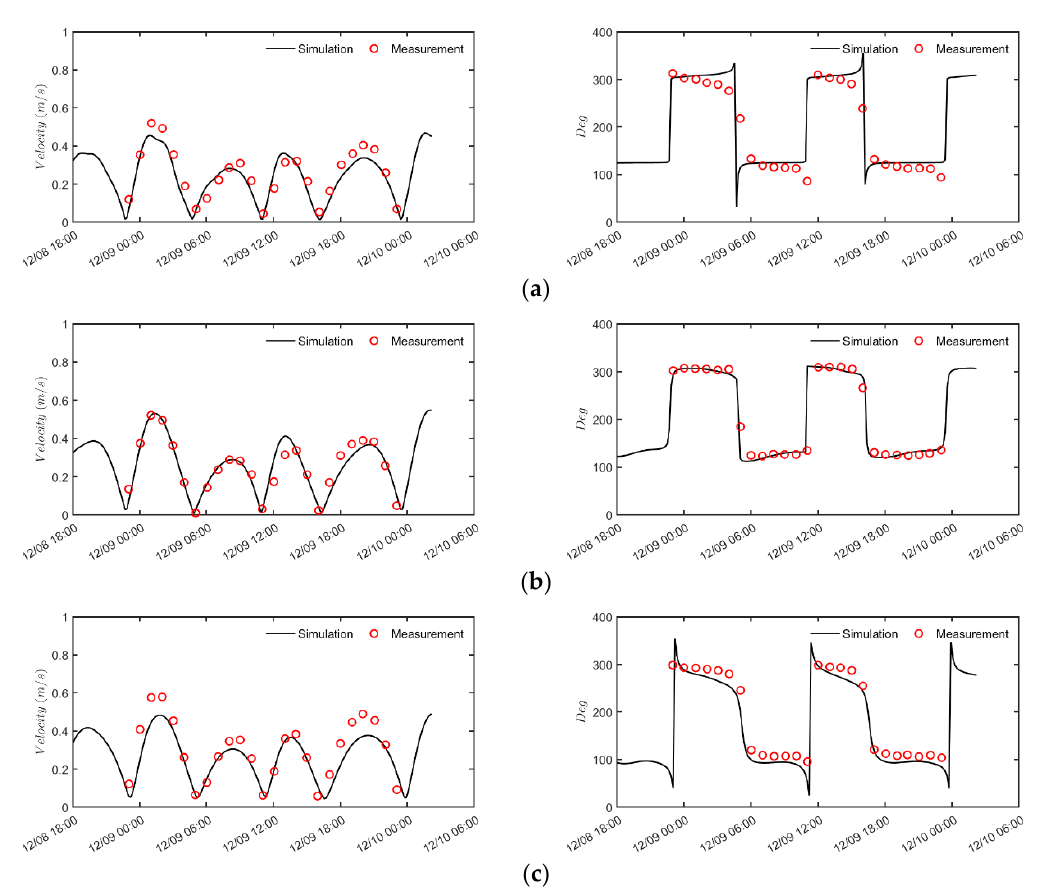
Figure 10. Comparison between the simulated results and the measured data for velocity (left column) and flow direction (right column) at Gauges P3, P4, and P5 for the Bohai Bay case. ( a ) P3; ( b ) P4; ( c )